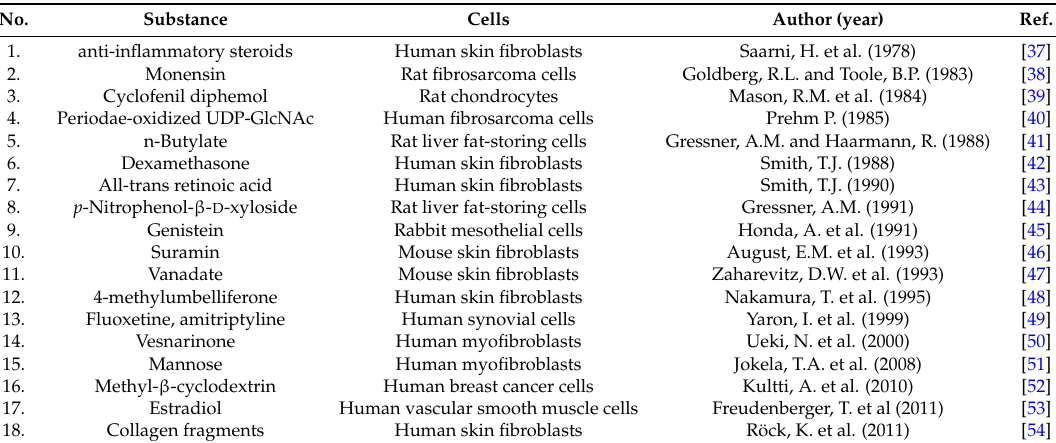
Table 1. The inhibitors of hyaluronan